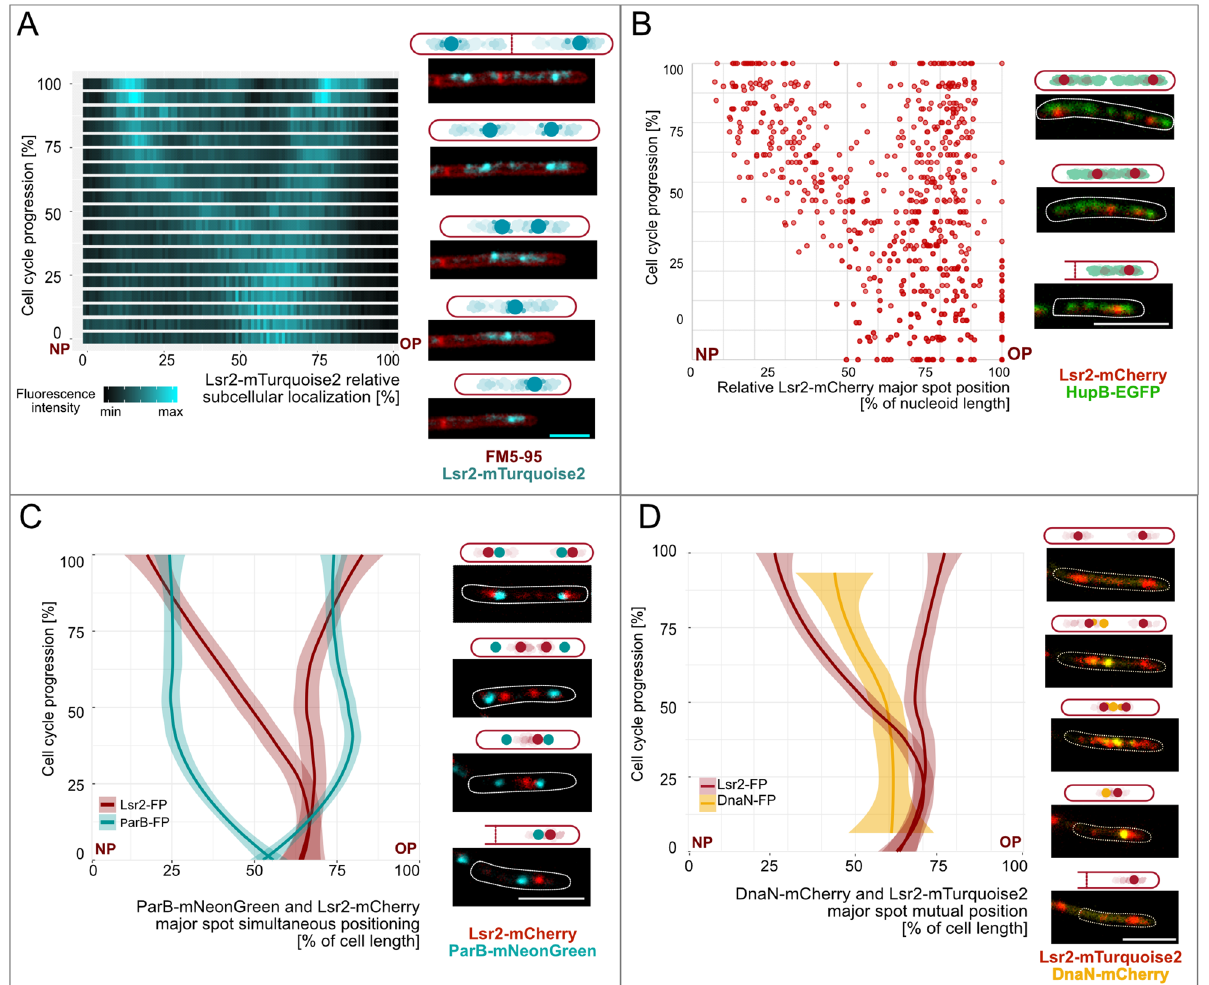
Figure 4. Subcellular localization of Lsr2-FP during the mycobacterial cell cycle. ( A ) Kymograph presenting real-time Lsr2-mTurquoise2 localization (n = 5, left panel) and micrographs of representative FM5-95-stained Lsr2-mTurquoise2 cells. Bar 2 µm (right panel). ( B ) Relative position of Lsr2-mCherry major foci along the nucleoid during the cell cycle (n = 26, left panel) and microscopic images of the Lsr2-mCherry_HupB-EGFP cell confirming that Lsr2-FP localized within the nucleoid area. Bar 5 µm (right panel). ( C , D ) Simultaneous positioning of the Lsr2-FP major foci and ParB-mNeonGreen ( oriC /segrosome) or DnaN-mCherry (replisome) signals over time (left panels). Also shown are graphs representing the averaged position of fluorescent proteins (dark-colored line) and the standard deviation (light-colored ribbon, n = 5). Lsr2-FP and the segrosome(s) localized near one another at the beginning and end of the cell cycle. For most of the C-period, in contrast, the major Lsr2-FP focus (foci) is (are) in close proximity to the replisomes. The images on the right of the sections show time-lapse microscopic images of representative Lsr2-mCherry_ParB-mNeonGreen or Lsr2- mTurquoise2_DnaN-mCherry cells. Bar 5 µm. NP new pole, OP old